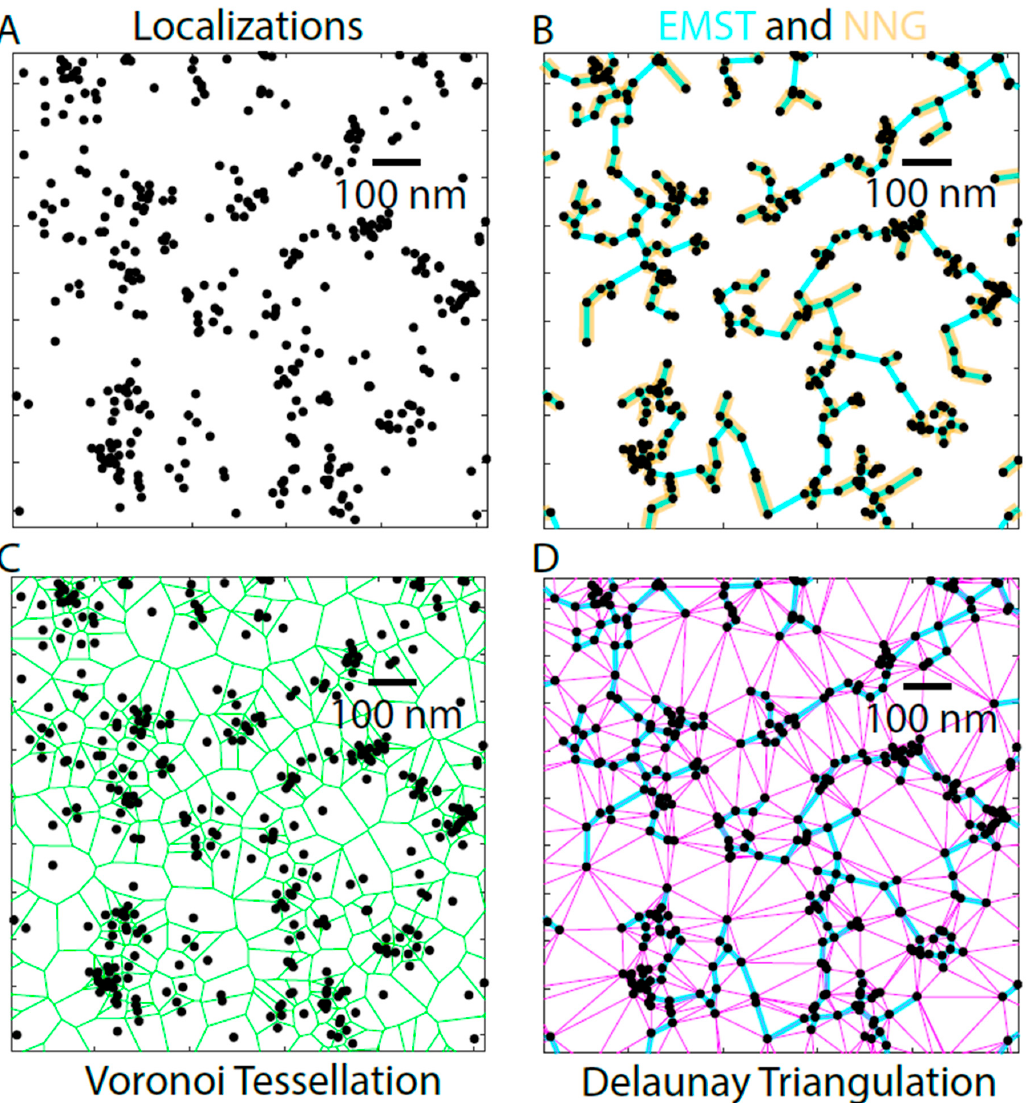
Figure 7. Graph Based Analysis of TIRF-STORM Image of a Human Dermal Fibroblast. TIRF-STORM localizations of fluorophores labeling Lamin A ( A ) are analyzed using several graph-based methods. The Euclidean Minimum Spanning Tree (EMST, cyan) connects all the detected fluorophores (dots) together using the shortest total line segment ( B ) and has been previously used to analyze lamin structures from single molecule localization microscopy [10]. A subgraph of the EMST is the Nearest Neighbor Graph (NNG, gold), which only connects fluorophore localizations with the next nearest localization without the requirement to connect all the fluorophores, as in EMST, and has been used to evaluate the relative density of A and B-type lamins [32]. The Voronoi Tessellation ( C ) draws lines (green) equidistant from two fluorophore coordinates resulting in polygons. The area within each polygon is the area closer to the single detected fluorophore contained within it than to fluorophores outside of the polygon and is used to approximate the reciprocal of the local fluorophore density. The Delaunay Triangulation [33,34] ( D ) (magenta) draws triangles between all the detected fluorophores, such that a circle drawn around the triangles does not contain another detected fluorophore, producing a more highly connected graph than the EMST. The EMST (cyan) is a subset of the edges of the Delaunay Triangulation (D) and the graphs are used to analyze the space between fluorophores. The nodes of the Voronoi are the centers of the circles going through the vertices of each triangle in the Delaunay Triangulation. Black scale bar is 100 nm.